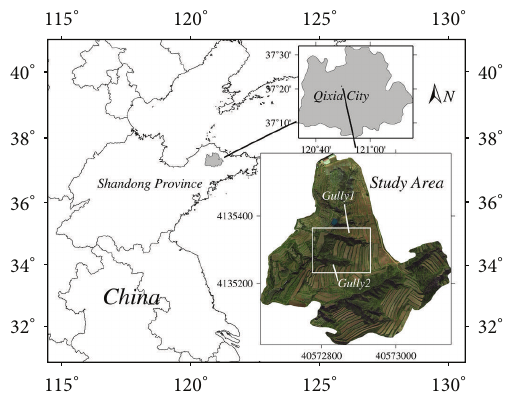
Figure 1: Location map of study gullies (Gully 1, Gully 2) at the Beiyanzikou catchmentin Qixia, eastern China.